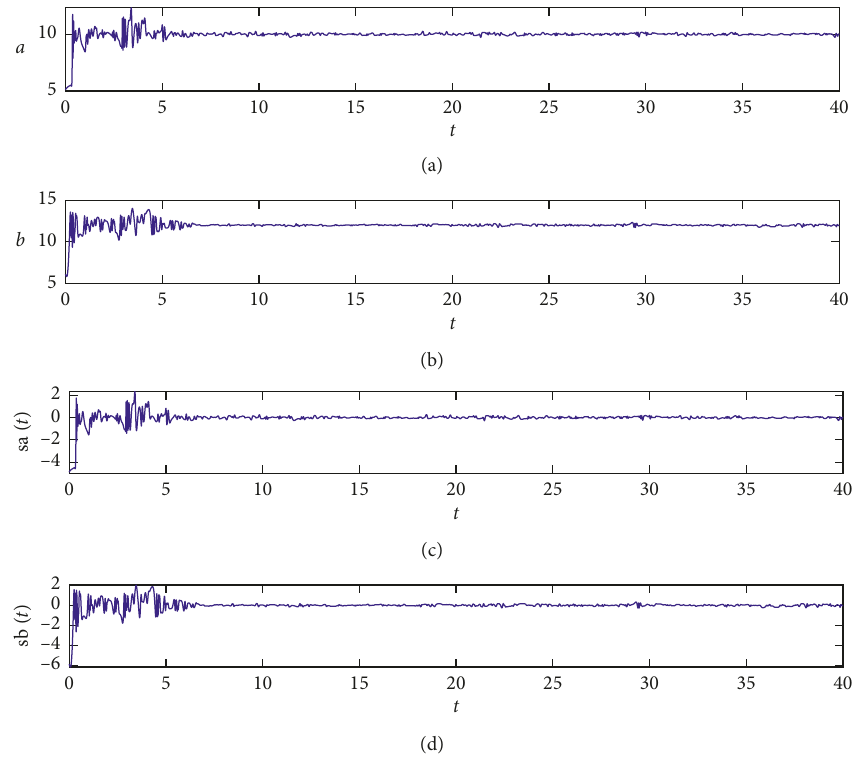
Figure 11: Estimation of uncertain parameters (a) and (b) and the recovered signal errors (c) and